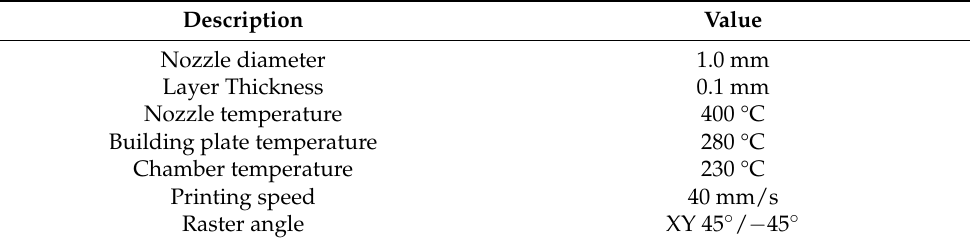
Table 1. 3D Printing